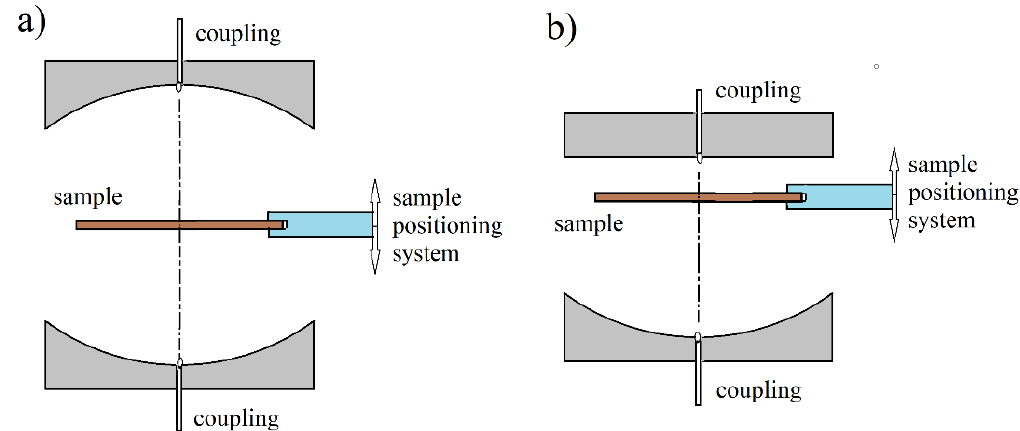
Figure 5. Fabry–Perot open resonators for measurements of low loss dielectrics at millimeter-wave frequencies [45]. ( a ) resonator with double concave reflectors, ( b ) resonator with plane and concave reflectors.